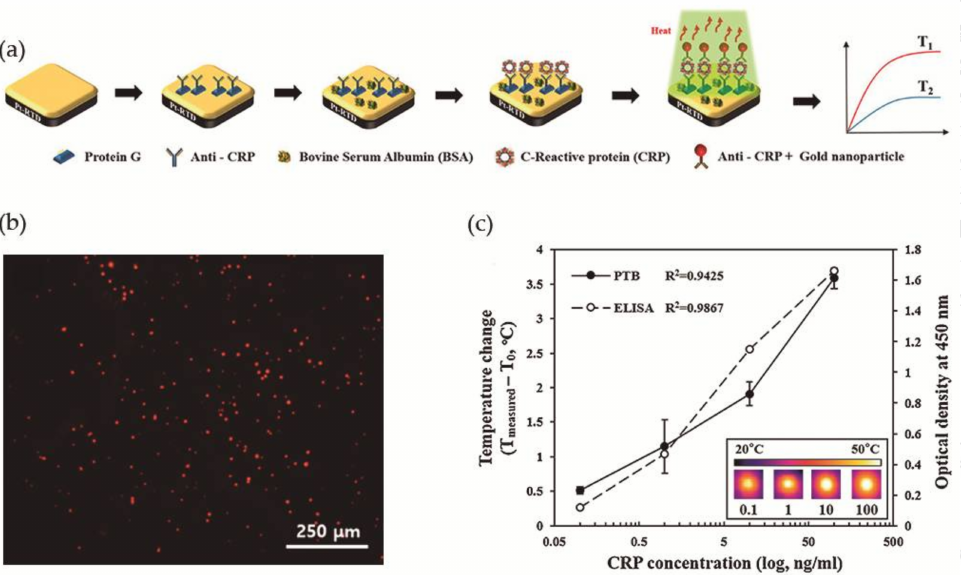
Figure 10. ( a ) Schematic illustration of the construction of the photothermal biosensor; ( b ) Fluorescence microscopy image of the biosensor in presence of CRP labeled with a fluorescent dye; ( c ) Evaluation of PTB and ELISA in the detection of different concentrations of CRP. Reproduced with permission from ref. [78]. Copyright Elsevier B. V.,